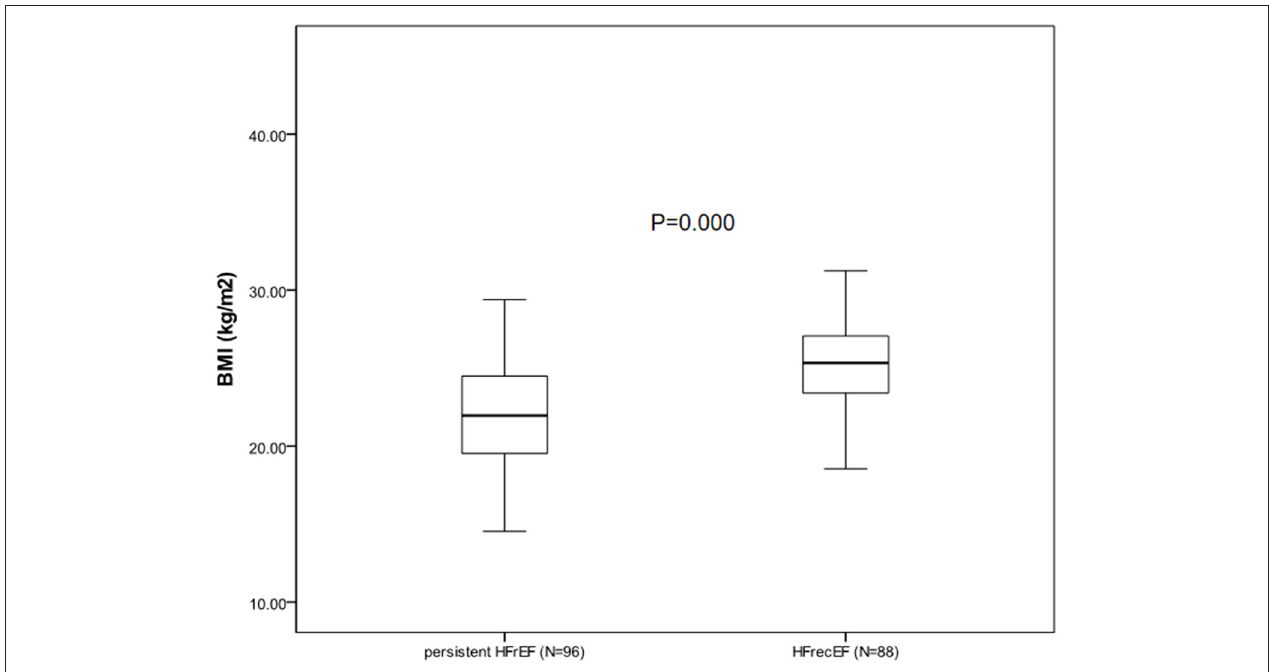
FIGURE 2 | Box plot comparing BMI value between HFrecEF and persistent HFrEF group.